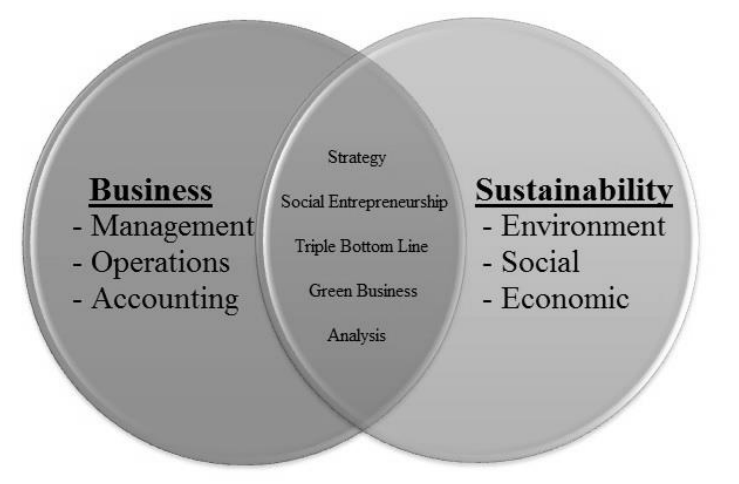
Figure 2: Example of Interdisciplinary Overlap between Business and